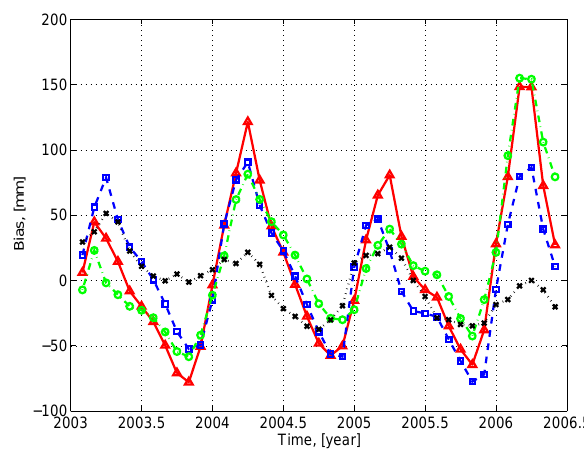
Fig. 4. Bias as a function of time between January 2003 and March 2006 for four target areas: upper Zambezi (red triangles), Zambezi (blue squares), upper Zambezi + Okavango (green circles) and Zam- bezi + Congo (black x-marks). 1000km Gaussian smoothing has been